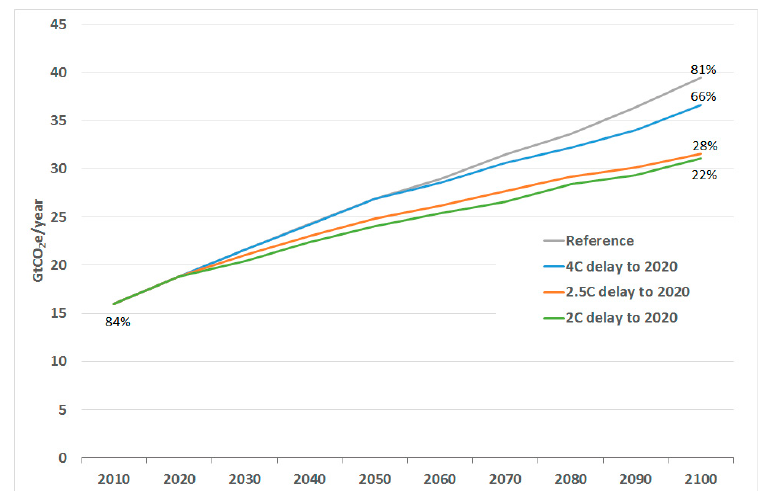
Figure 3. Non-CO 2 GHG emissions savings (relative to unmitigated reference scenario) from CO 2 mitigation measures, in a range of scenarios targeting different long-term temperatures with global mitigation action delayed to 2020. Notes: Percentage figures show the share of fossil fuels in total primary energy supply in 2010 and 2100 for each